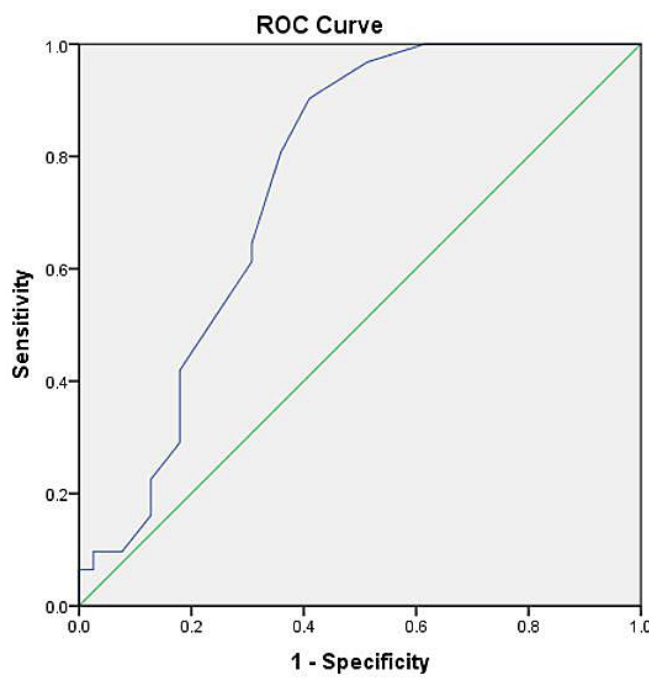
Figure 1. ROC analysis of PRISM III score for prediction on short-term mortality in PARDS. The blue line represents ROC curve for PRISM III score regarding the prediction of the short-term outcome. The green line is a diagonal reference line. Notes: Area under the ROC curve 0.755, SE 0.058, 95% CI 0.641 – 0.870, p < 0.001, Overall Sensitivity 64.1%, Overal Specificity 80.6%, Positive Predictive Value 0.860, Negative Predictive Value 0.641 .